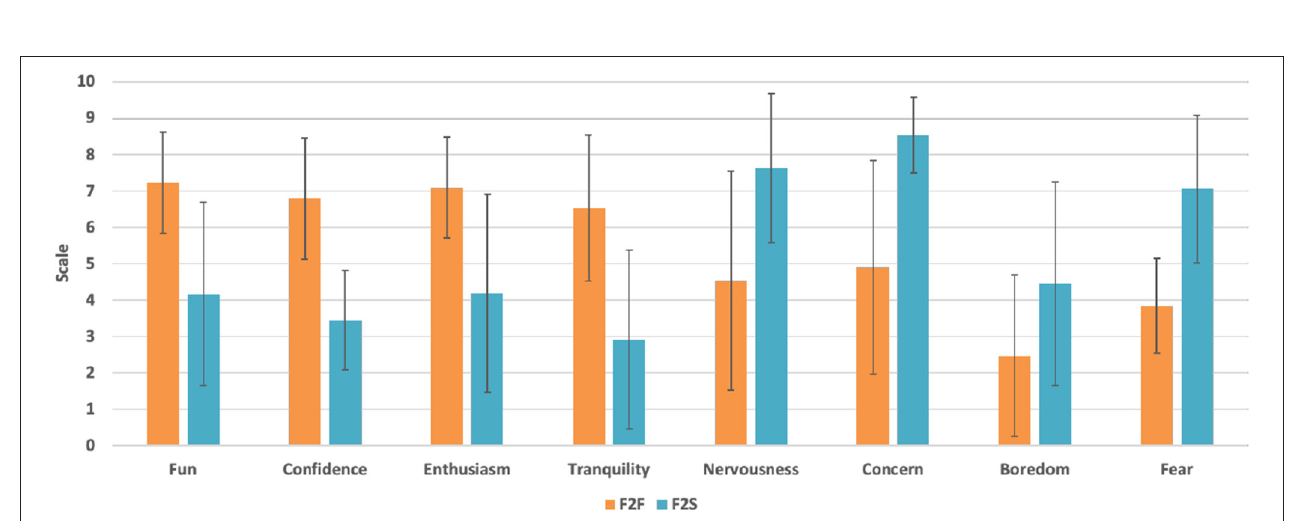
FIGURE 3 | Single item assessment of the emotions for F2F and F2S flipped classroom after the course completion.